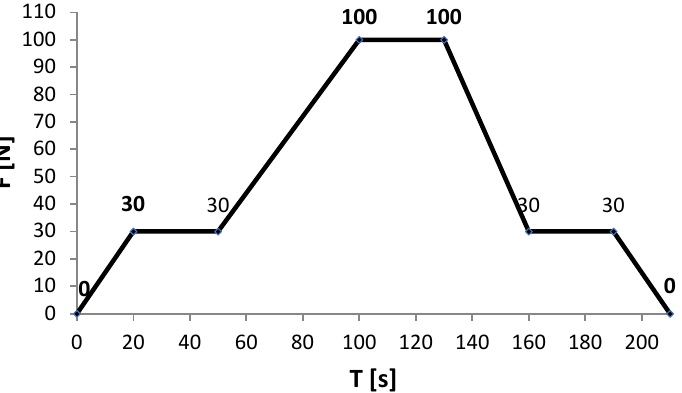
Figure 3. The course of mechanical load while testing lateral stiffness of firefighting helmet shells.